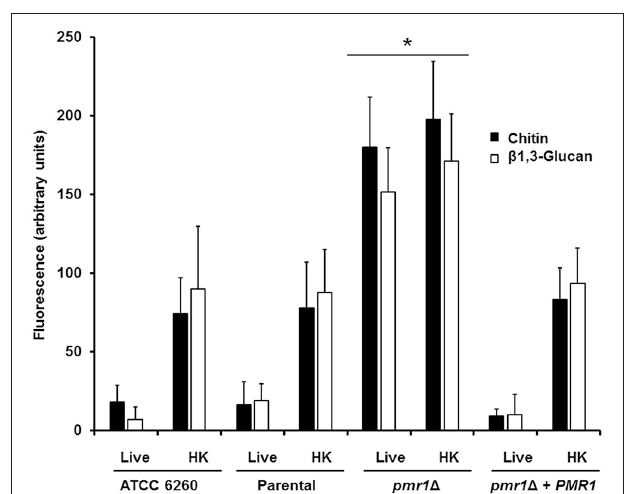
FIGURE 4 | The cell-wall structural polysaccharides, chitin and β 1,3-glucan, are significantly exposed at the cell surface of the C. guilliermondii pmr1 1 null mutant. Live or heat-killed (HK) yeast cells were incubated with either fluorescein isothiocyanate-wheat germ agglutinin conjugate (closed bars, labels chitin) or IgG Fc-Dectin-1 chimera (open bars, labels β 1,3-glucan) as described in the Experimental procedures, inspected under fluorescence microscopy, and the fluorescence associated to 100 individual cells recorded. The strains used are: ATCC 6260, KU141 (Parental), HMY134 ( pmr1 1 ) and HMY138 ( pmr1 1 + PMR1 ) * P < 0.05, when compared with live and HK cells from KU141, HMY134, and HMY138